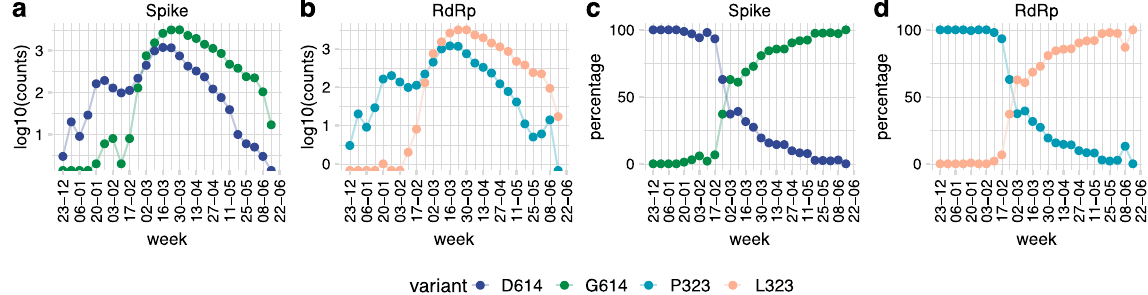
Figure 3. Two major protein variants of SARS-CoV-2: S protein D614G and RNA-dependent polymerase P323L. Available high-quality sequences of SARS-CoV-2 (27,084) were analysed for the D614 and G614 variants of the S-protein and the P323 and L323 of the RdR polymerase. Data are shown as total number of sequences per week ( a , note the logarithmic scale) or percent of sequences per week ( b